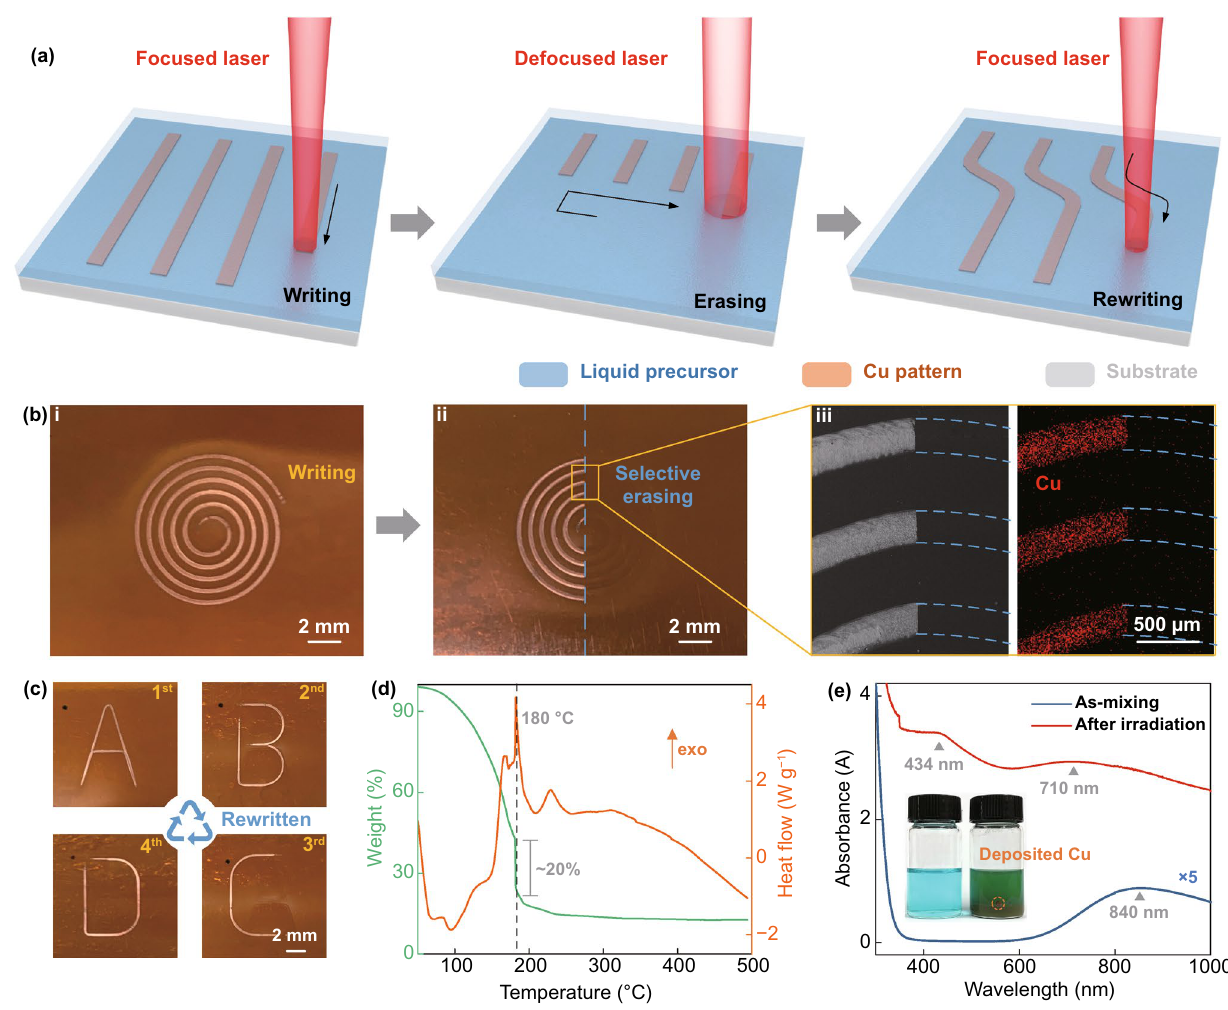
Fig. 1 Demonstration of erasable laser writing process and the precursor characterization. a Schematic of the all-laser writing–erasing–rewrit- ing process. b Characterization of the pattern during writing–erasing process. Digital photos of the (i) as-written pattern (ii) after selective eras- ing, and (iii) SEM and EDS images. c Letters successively written and erased at a same region on the substrate. The black dot is a deliberate mark for this region. d DSC and TGA curves of the precursor. e UV–vis spectra of the precursor (diluted to 1/200 using EG) before and after laser irradiation. Inset photos show the solution change after irradiation, whereof the dotted circle marks the deposited Cu on the glass